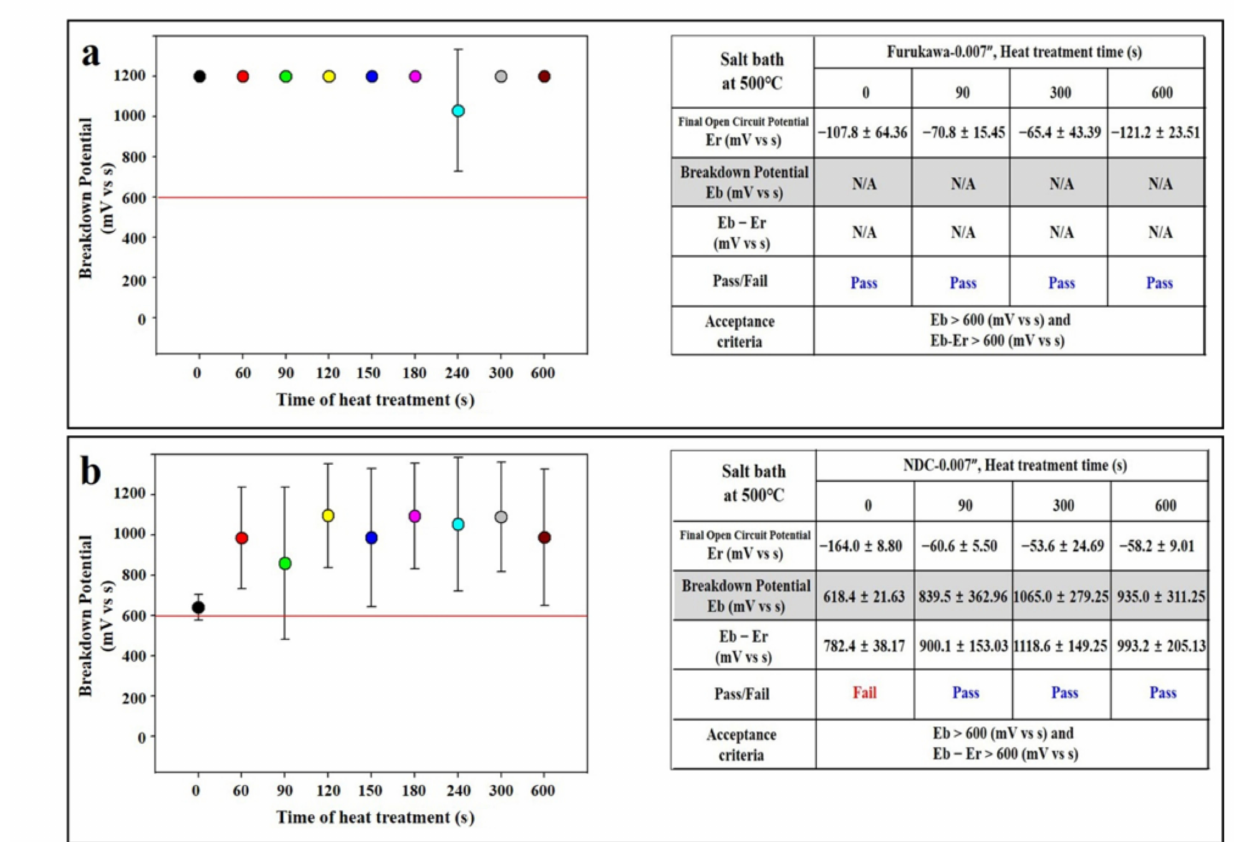
Figure 3. Heat treatment of wires in salt bath. ( a ) Furukawa and ( b ) NDC wire. Red lines indicate acceptance criteria in this study as mentioned in Materials and Methods section. ‘F’ and ‘N’ are acronyms for ‘Furukawa’ and ‘NDC’,